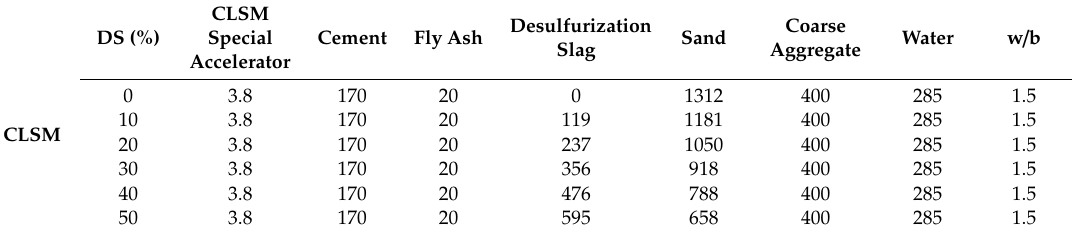
The controllable low-strength material (CLSM) mixing proportions (unit: kg / m 3 ). w / b: water-binder